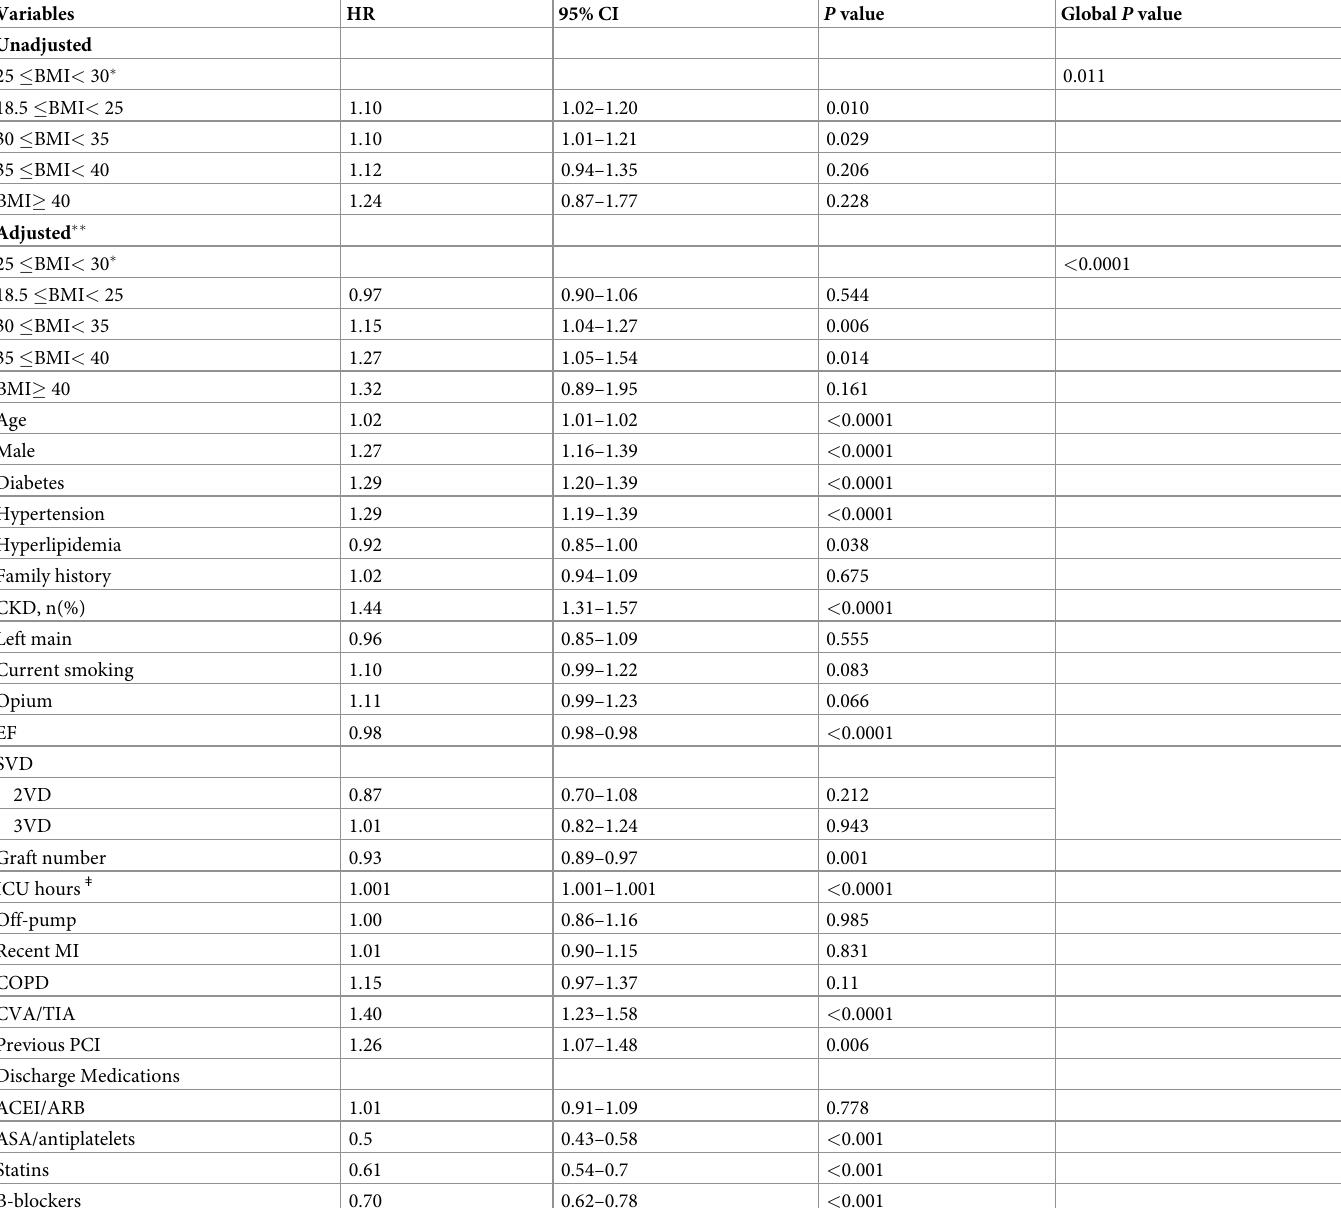
Table 3. Effects of different levels of BMI on 5-year MACCEs after isolated coronary artery bypass graft